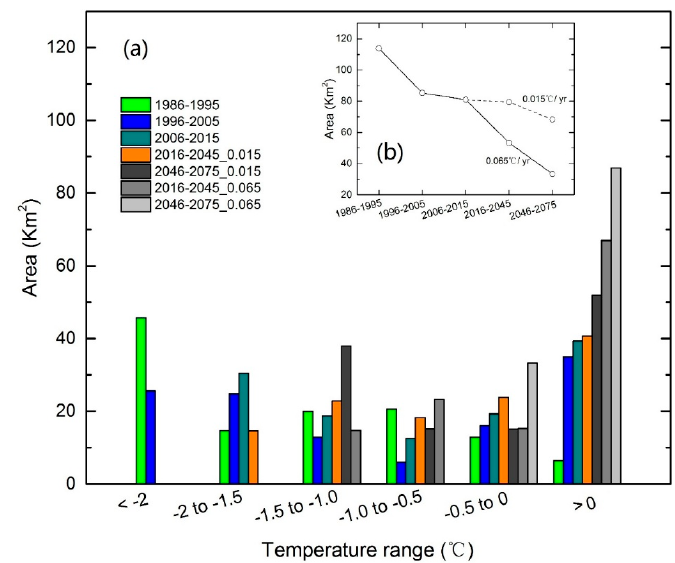
Figure 8. Statistics of modeled ground temperature distribution. ( a ) MAGTs at 10 m depth for different temperature ranges; ( b ) permafrost area evolution.